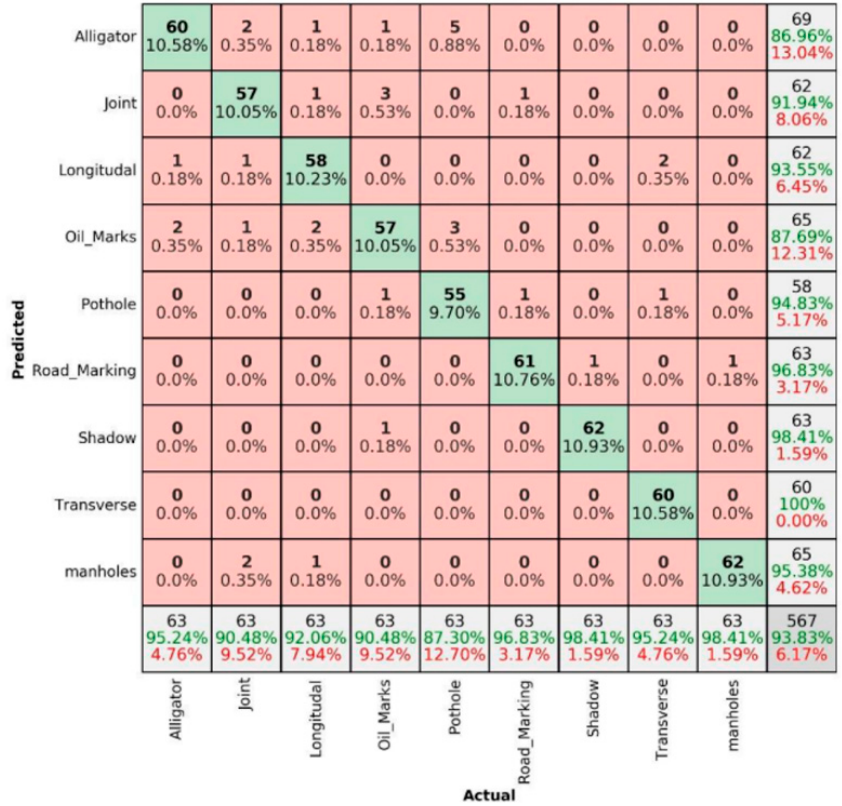
Figure 8. Winter sunny condition—DC images.